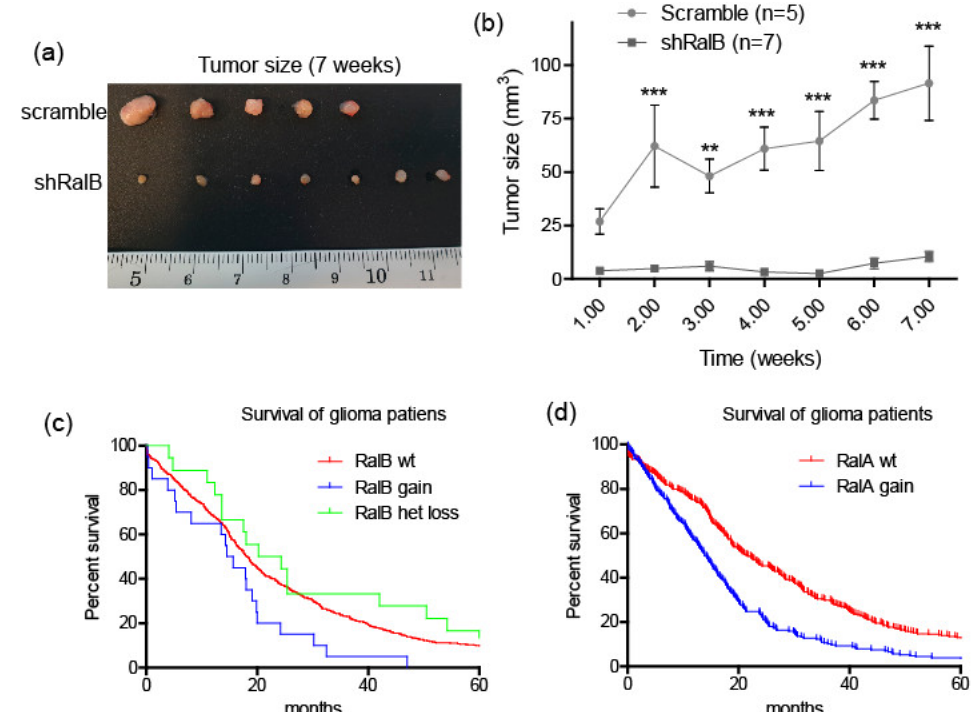
Figure 7. Ral GTPases downregulation prevents the growth of GBM cells in vivo. ( a ) Human U251-MG cells were infected with lentiviruses harboring scramble or shRalB. Infected cells were inoculated subcutaneously in immunodeficient SCID male mice. Tumor sizes were measured every week. Mice were euthanized seven weeks after injection and the tumors excised. ( b ) Quantification of tumor size at different weeks. Data is mean ± SEM. Significance was calculated by two-way ANOVA and Bonferroni-HSD post-test. Significance of scramble versus shRalB group is represented (** p ≤ 0.01; *** p ≤ 0.001). ( c ) Analysis of survival times (months) of glioma patients (TCGA cohort of diffuse gliomas, Gliovis) with a Kaplan–Meier plot comparing the effects of copy number increase of RalB (gain; n = 20), heterozygous loss of RalB (het loss; n = 18), and wild type RalB alleles (wt.; n = 600). The median survival in months was 15.1 (RalB gain), 18.1 (RalB wt.), and 22.25 (RalB het loss), with p = 0.048 (Mantel–Cox test). ( d ) Analysis of survival times (months) of glioma patients as in ( c ). RalA copy number increase (gain; n = 226) and wild type RalA alleles (wt.; n = 417). The median survival was 13.8 (RalA gain) and 21.55 (RalA wt.), with p < 0.0001 (Mantel–Cox test).